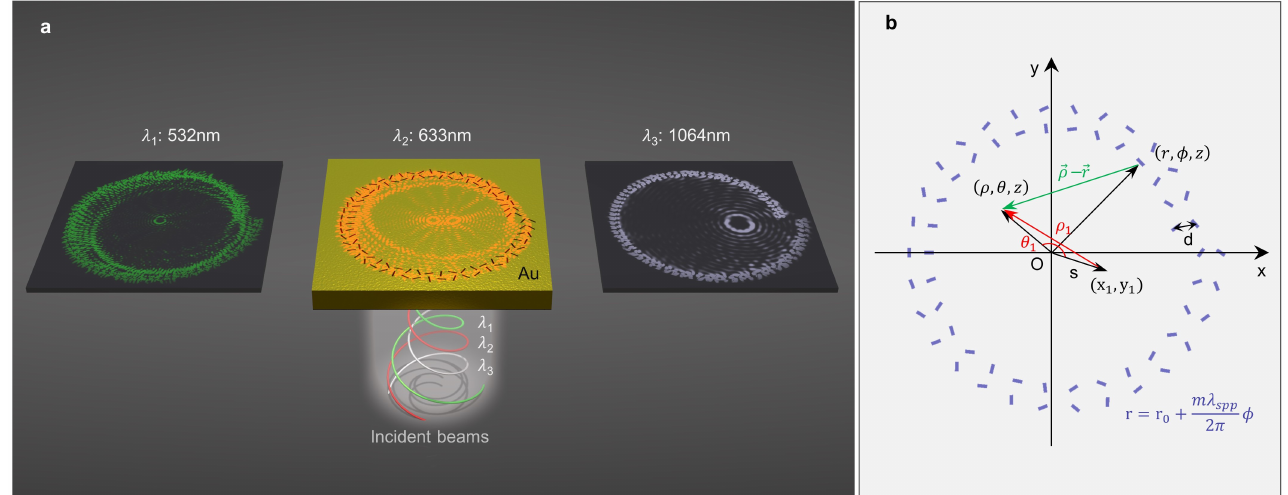
Figure 1. Tunable excitation of SPP waves carrying OAM. ( a ) Schematics of a plasmonic vortex generator. The launched SPP waves with varying topological charges at a predesigned location can be generated by illuminating light with different wavelengths (green: 532 nm, red: 633 nm, grey: 1064 nm). ( b ) Schematic diagram of the plasmonic metasurface, with the phase controlled by the orientation of paired perpendicular